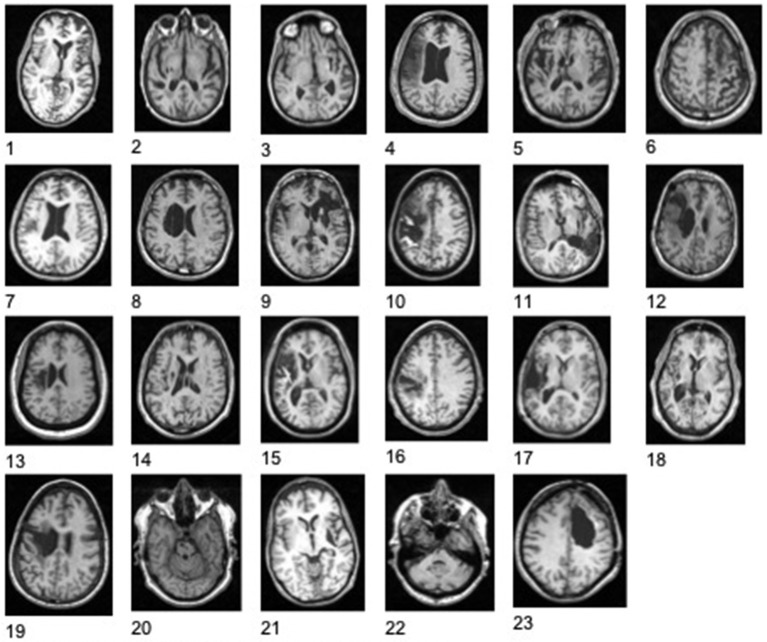
Illustrations of stroke lessions. Right side of each image represents right hemisphere.